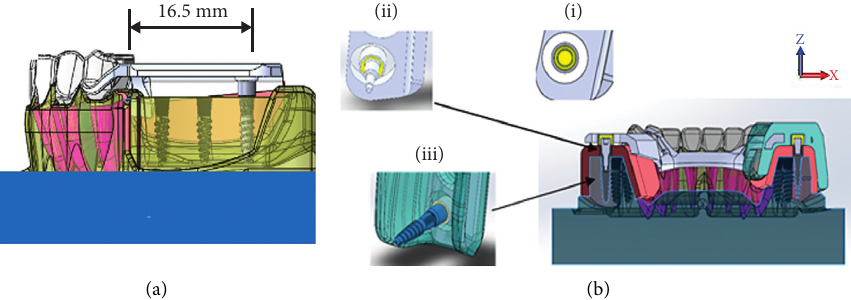
Figure 4: The relationship among the mini dental implant, equator attachment system, and the prepared model with RPD framework with acrylic base on edentulous areas: (a) the placement of mini dental implant at 16.5mm distal to the distal surface of the last abutment tooth on both sides of edentulous ridges and (b) the silicon cap within the acrylic base attached on the RPD framework (i), the connection between the equator attachment and silicon cap within the acrylic base (ii), and the connection of the mini dental implant to the equator attachment system within acrylic base (iii).